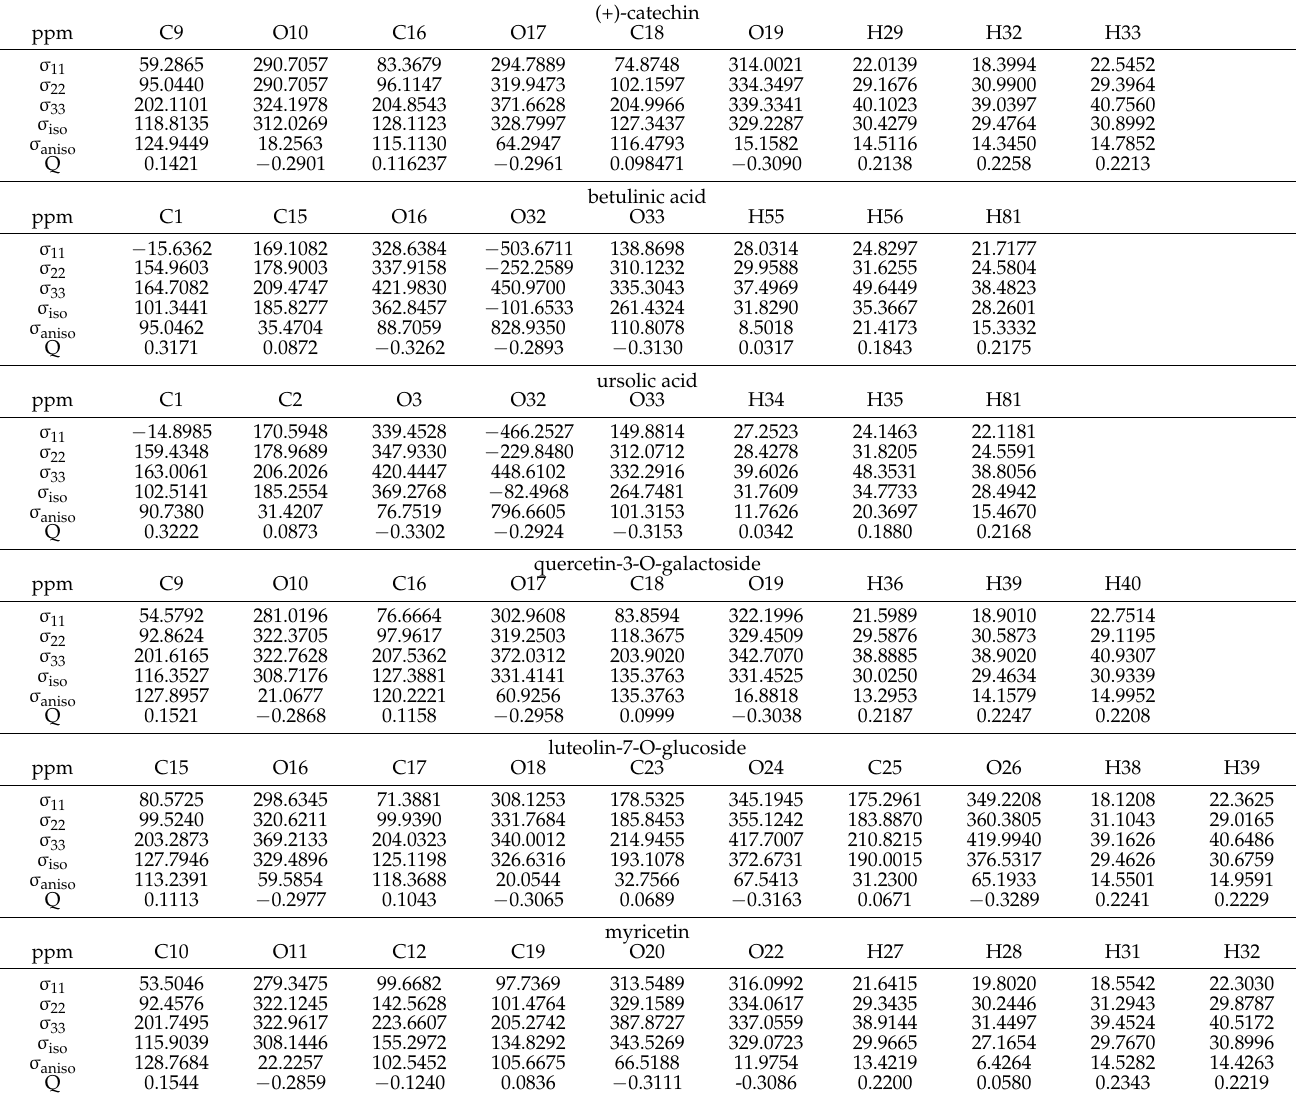
Table 1. The results of SCF GIAO magnetic shielding tensor and atomic charge (Q) for (+)-catechin, betulinic acid, ursolic acid, quercetin-3-O-galactoside, luteolin-7-O-glucoside, and myricetin in ppm joint at the adsorption site of (6,6) armchair